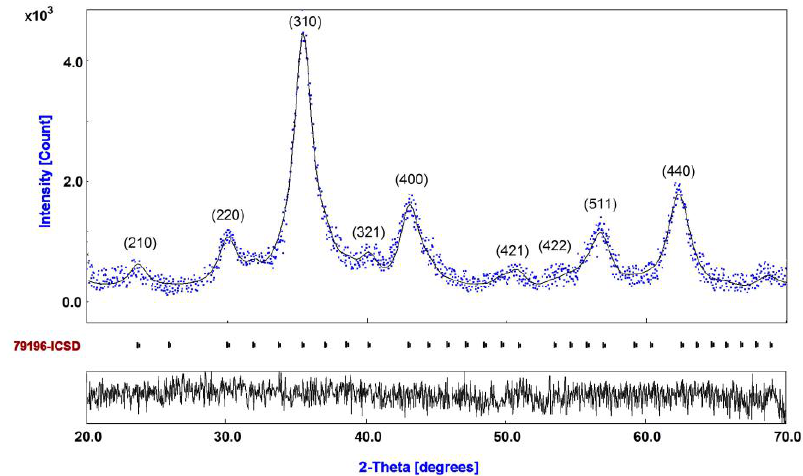
Figure 1. Observed and calculated diffraction pattern of γ -Fe 2 O 3 coated with dextran. Experimental (blue), calculated (solid line gray), and difference plot (lower line).